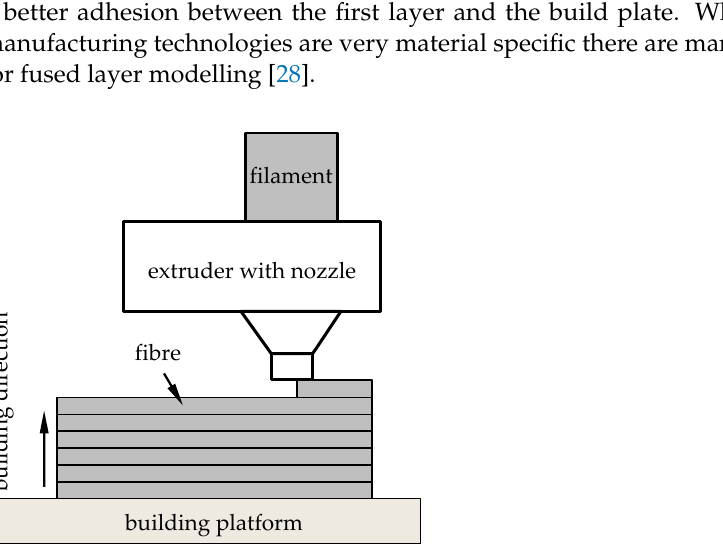
Figure 11. Schematic representation of fused filament fabrication (based on the work in [37]). In addition to the often-used plastics, also gel-like or liquid materials are used, for example, in medical applications. L I et al. [38] present such a procedure for direct skin reconstruction.